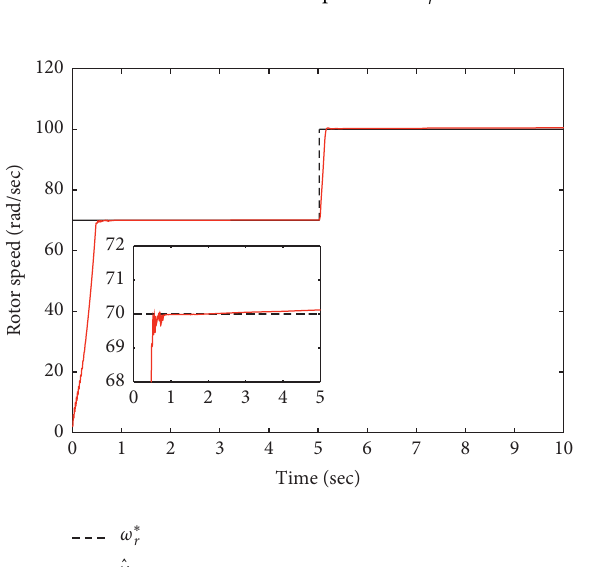
Figure 6: Evolution of output by using the proposed robust Figure 4: The time profile of 􏽢 ω r . predictive control